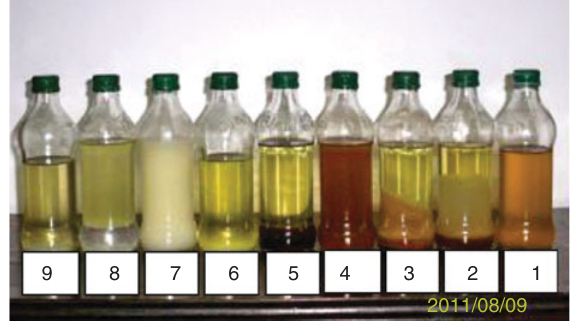
Fig. 1. Biodiesel production steps: 1 (cid:2)